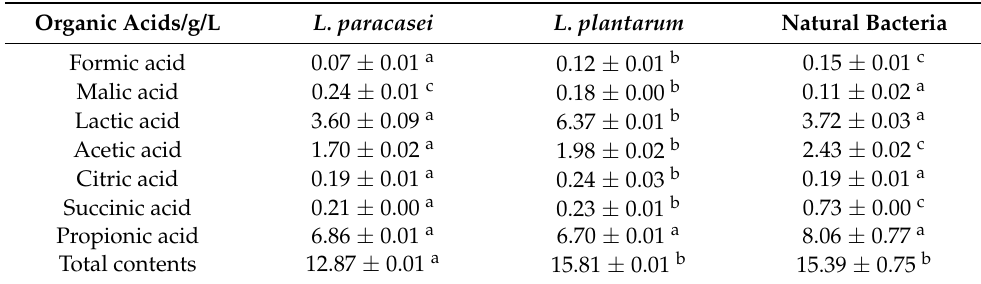
Table 4. Organic acids in tofu manufactured from coagulant fermented by L. paracasei and L. plantarum and natural